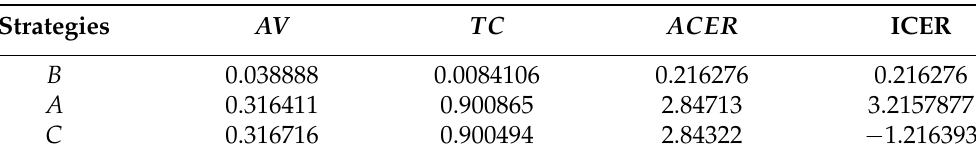
Table 5. Incremental cost-effectiveness ratio for strategies A , B , and C . Parameters according to Tables 1 and 3 with C 1 = C 2 = 1 and α = 1.